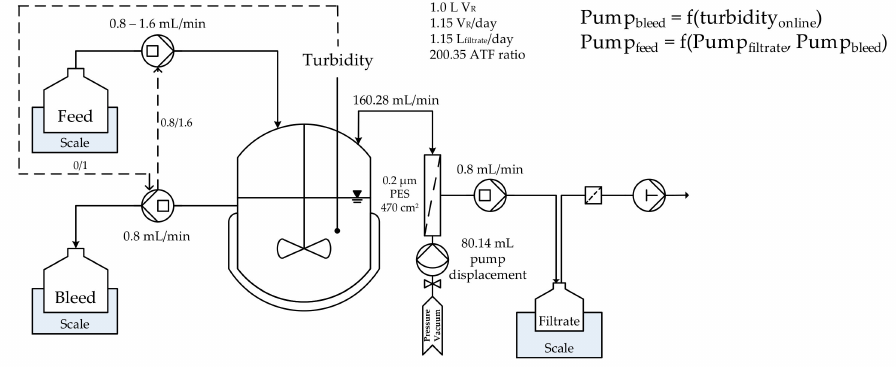
Figure 5. Schematic overview of the turbidostat perfusion cultivation including control strategy for viable cell concentration via turbidity, feed, and bleed